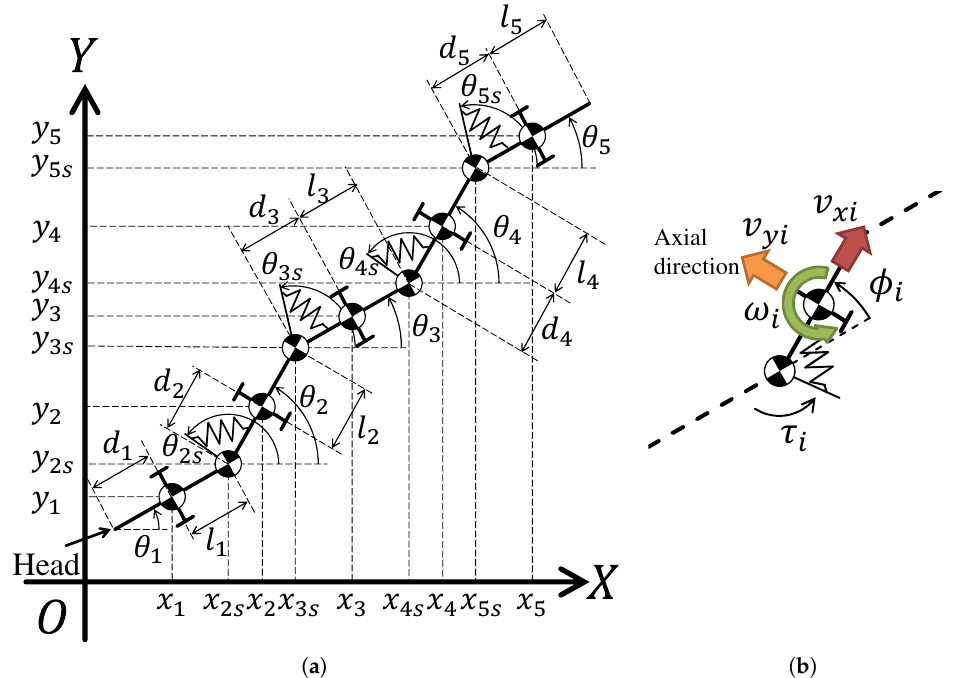
Figure 1. Schematic figure of a five-link snake-like robot with rotational elastic actuators (REAs). ( a ) Definition of the generalized coordinate. ( b ) Definitions of both the quasi-velocity and the relative angle. The springs are installed between links, and are driven by the motor installed on the end edge of the anterior link. The posterior link is driven by the spring. From panel a, τ 1 and τ 6 are nonexistent (i.e., τ 1 = τ 6 = 0). Table 1. Physical parameters ( i = 1, · · · , 5, j = 2, · · · , 5).